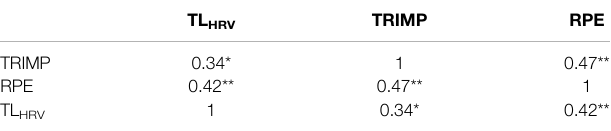
TABLE 4 | Correlation between TL HRV and internal measured